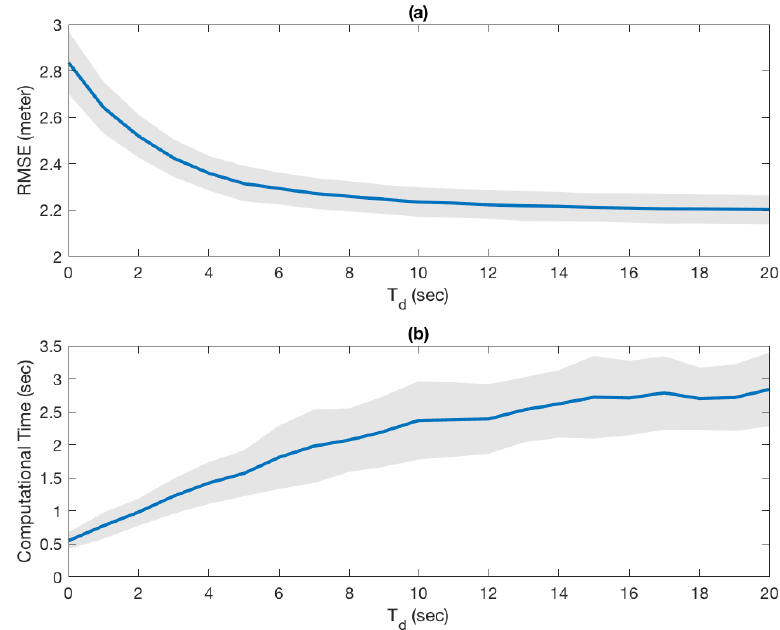
Figure 10. Performance of Extended Kalman fileter. ( a ) (RMSE) between the true paths and estimated trajectories with respect to the maximum delay; ( b ) Computational time with repect to the maximum delay. The gray bands indicate 1 standard deviation from the